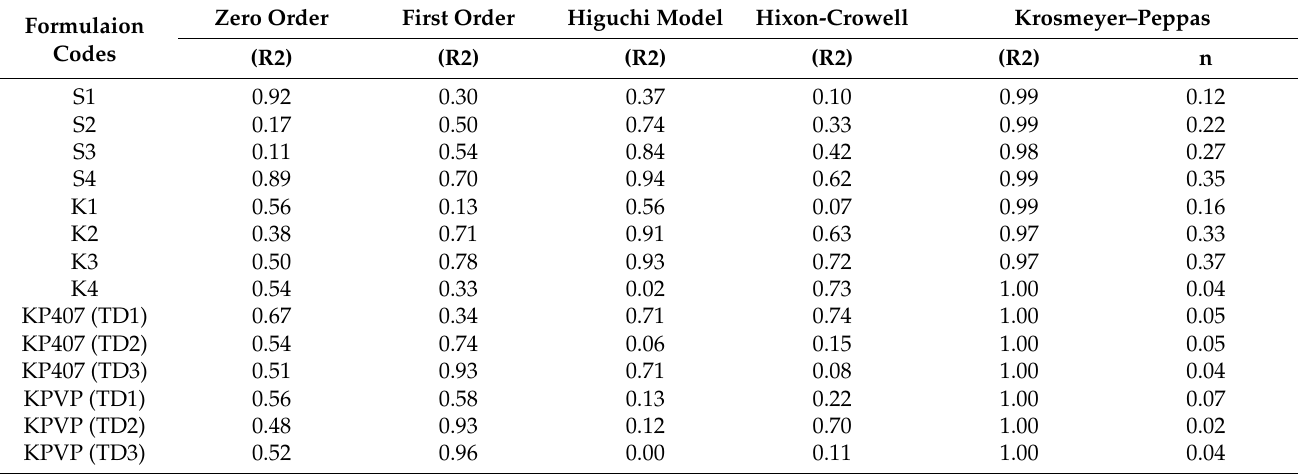
Table 6. Kinetic modelling data of prepared solid dispersion formulations from drug release data in 0.1 N